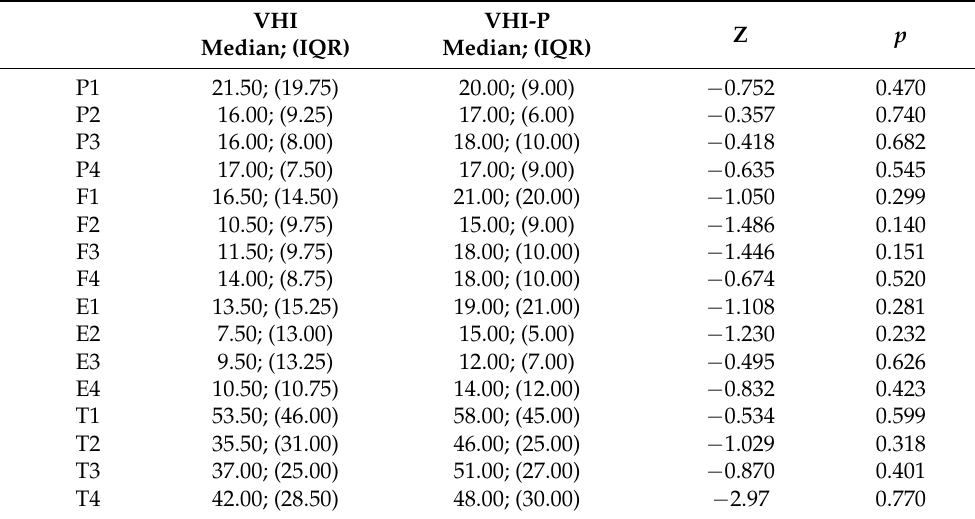
Table 4. Analysis of comparison of VHI and VHI-P across domains from pre-to-24 months post-